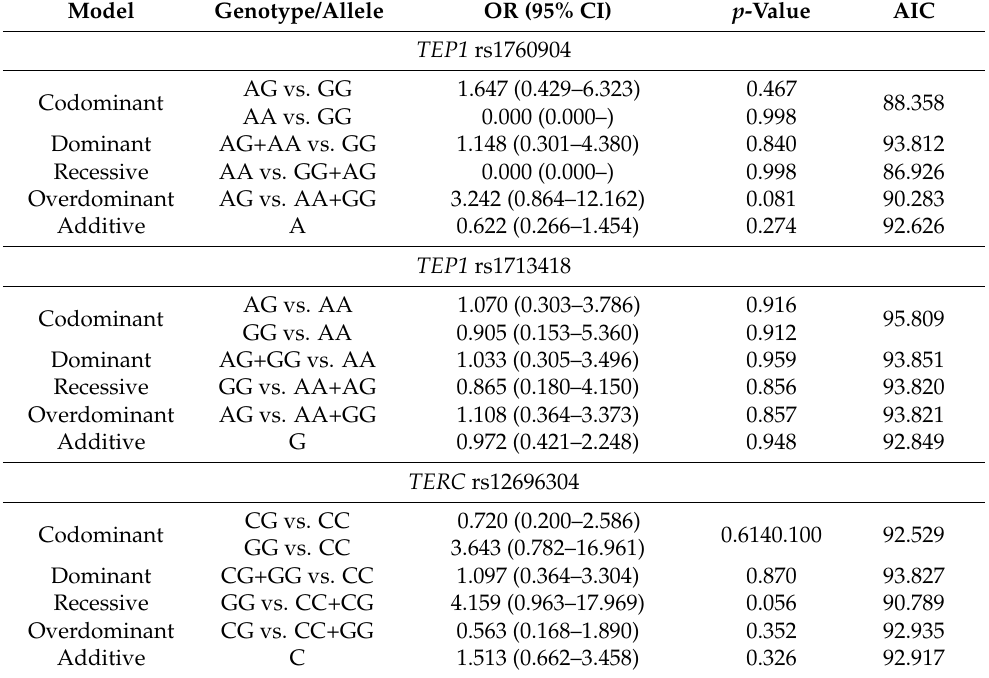
Table 3. Influence of TEP1 rs1760904, rs1713418, TERC rs12696304 on LHON development.